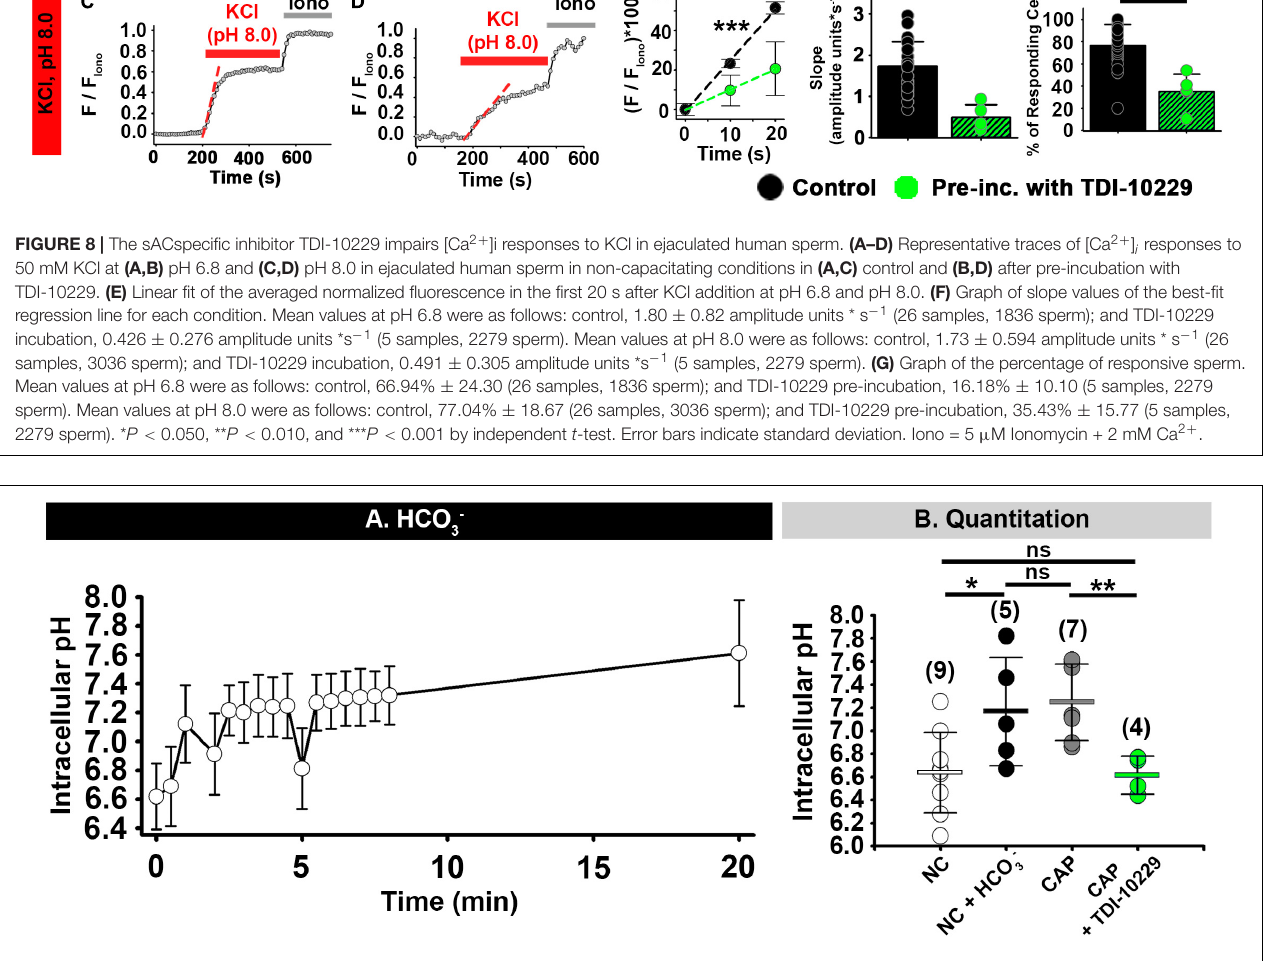
FIGURE 9 | HCO 3 − - induced increase of intracellular pH depends on sAC activity. (A) Mean and standard deviation values of intracellular pH in mouse epididymal sperm after addition of 15 mM HCO 3 − at 0 min) ( n = 3 mice). (B) Graph showing sperm intracellular pH values after 60 min incubation in the indicated conditions. NC, non-capacitating; CAP, capacitating. Horizontal bars indicate mean and standard deviation. Mean values for intracellular pH were as follows: NC, 6.64 ± 0.349 (9 mice); NC + HCO 3 − , 7.17 ± 0.469 (5 mice); CAP, 7.25 ± 0.331 (7 mice); and CAP + TDI10229, 6.62 ± 0.164 (4 mice) respectively. Numbers in parentheses are numbers of animals. * P < 0.05 and ** P < 0.01 by one-way ANOVA. ns,